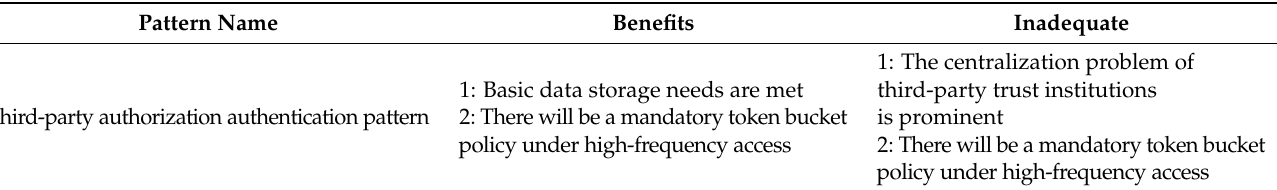
Figure 7. Third-party authorization authentication pattern. Table 5. Third-party authorization authentication pattern characteristics